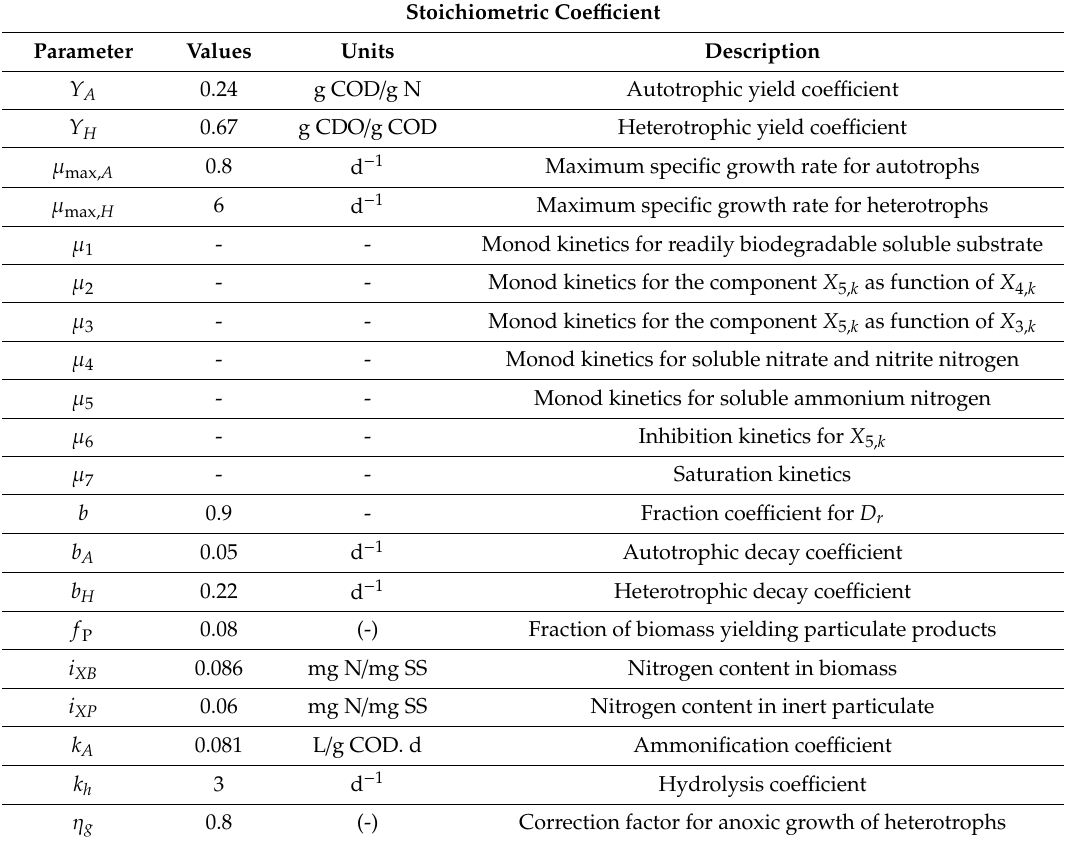
Table A1. Mathematical model